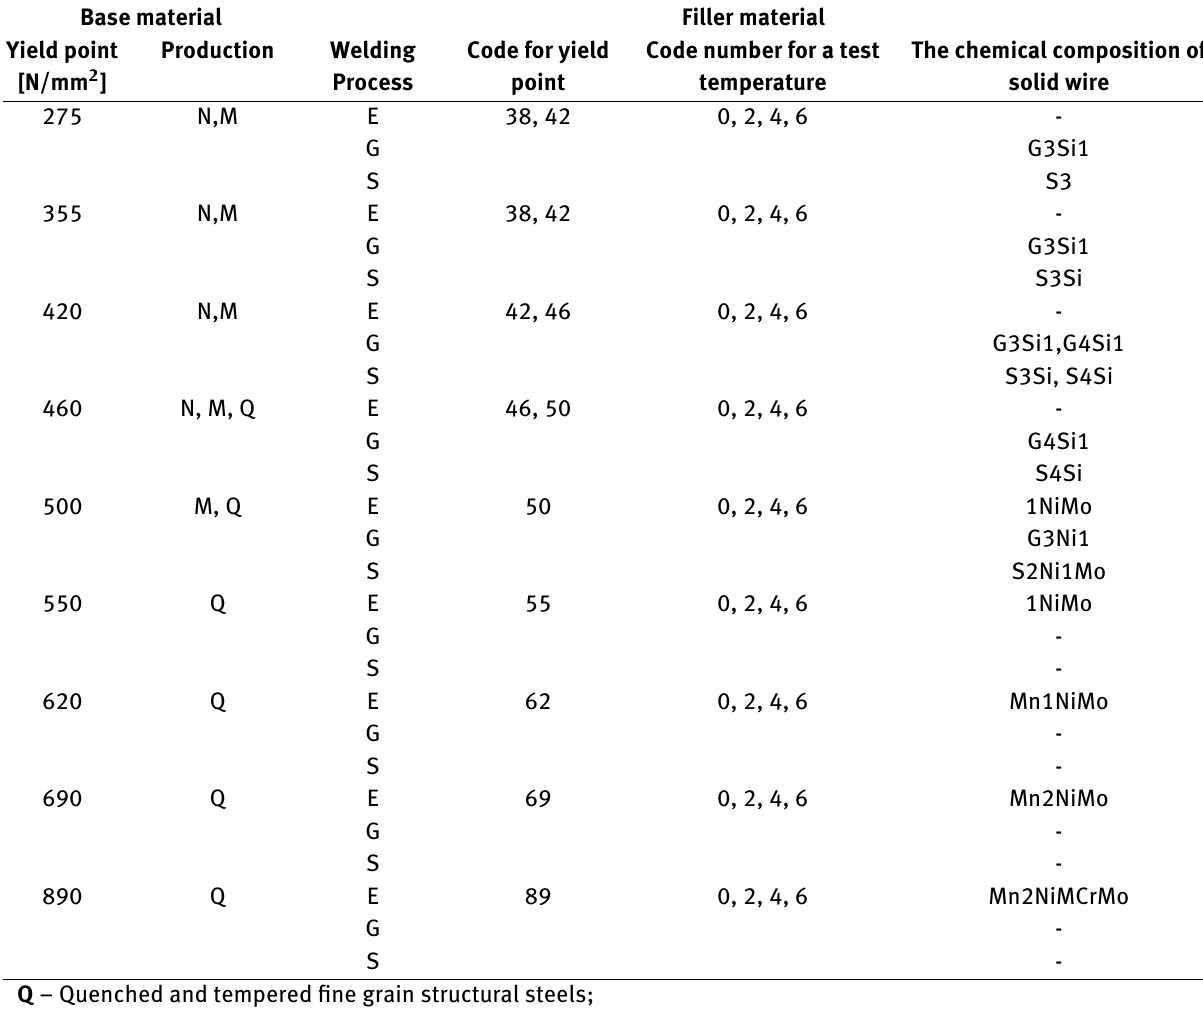
Table 1: Recommendations for base material-filler material allocations with fine-grain structural steels. G. Schulze // Heidelberg-Dordrecht. (2009). ©2009 Springer